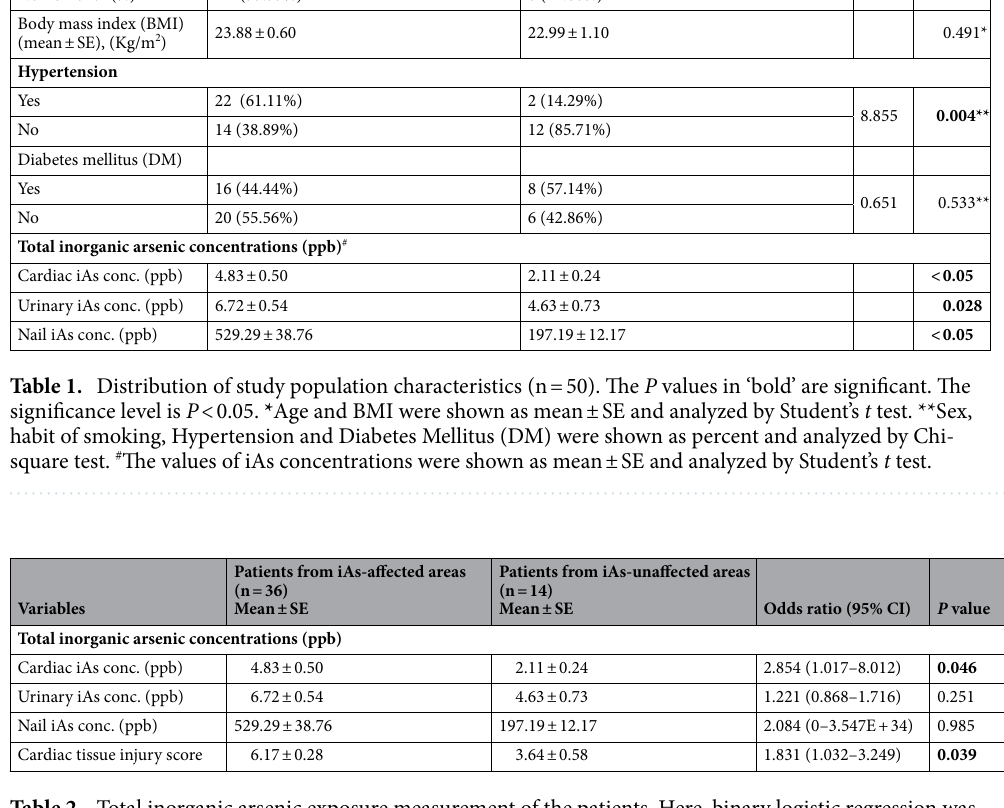
Table 2. Total inorganic arsenic exposure measurement of the patients. Here, binary logistic regression was done for the association between patients’ residence with the measured arsenic in cardiac tissue, urine and nail by adjusting the analysis for age, sex, BMI, hypertension and diabetes status of the patients. Significant values ( P < 0.05) are typed in bold font.